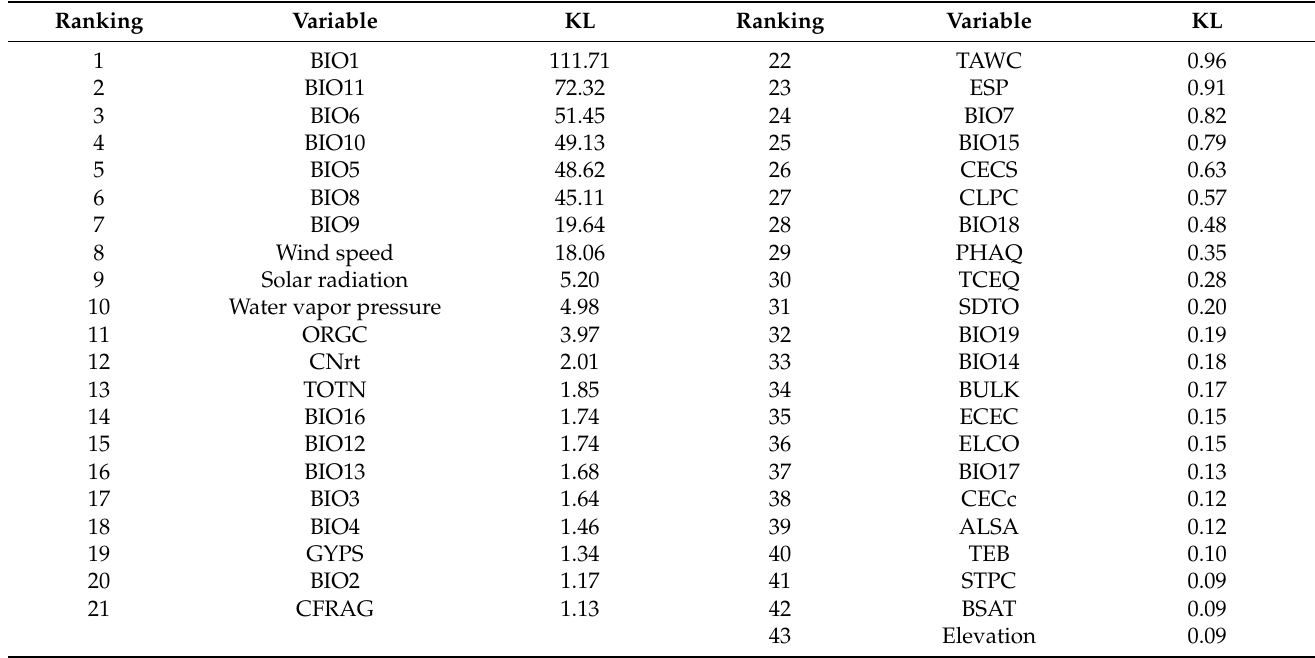
Table A3. KL values and rankings of all the environmental variables (except for